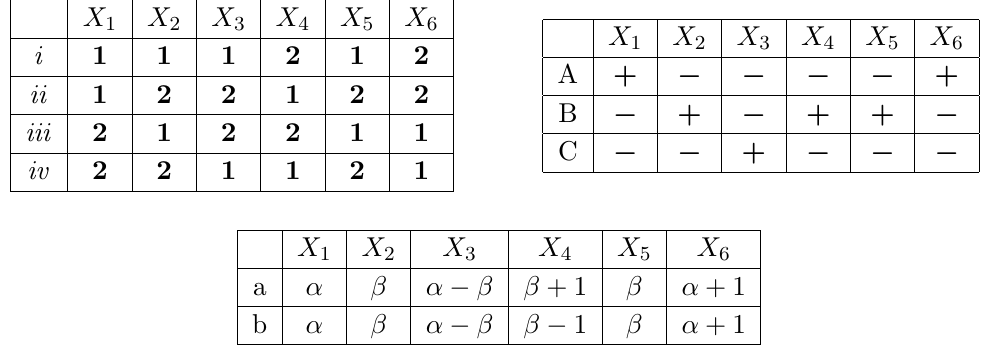
Table 17. SU ( 2 ) L (upper left), Z 2 (upper right) and U ( 1 ) Y (bottom) assignments for particles X 1 to X 6 of diagrams 3.a and 3.b in (cid:12)gure 3.